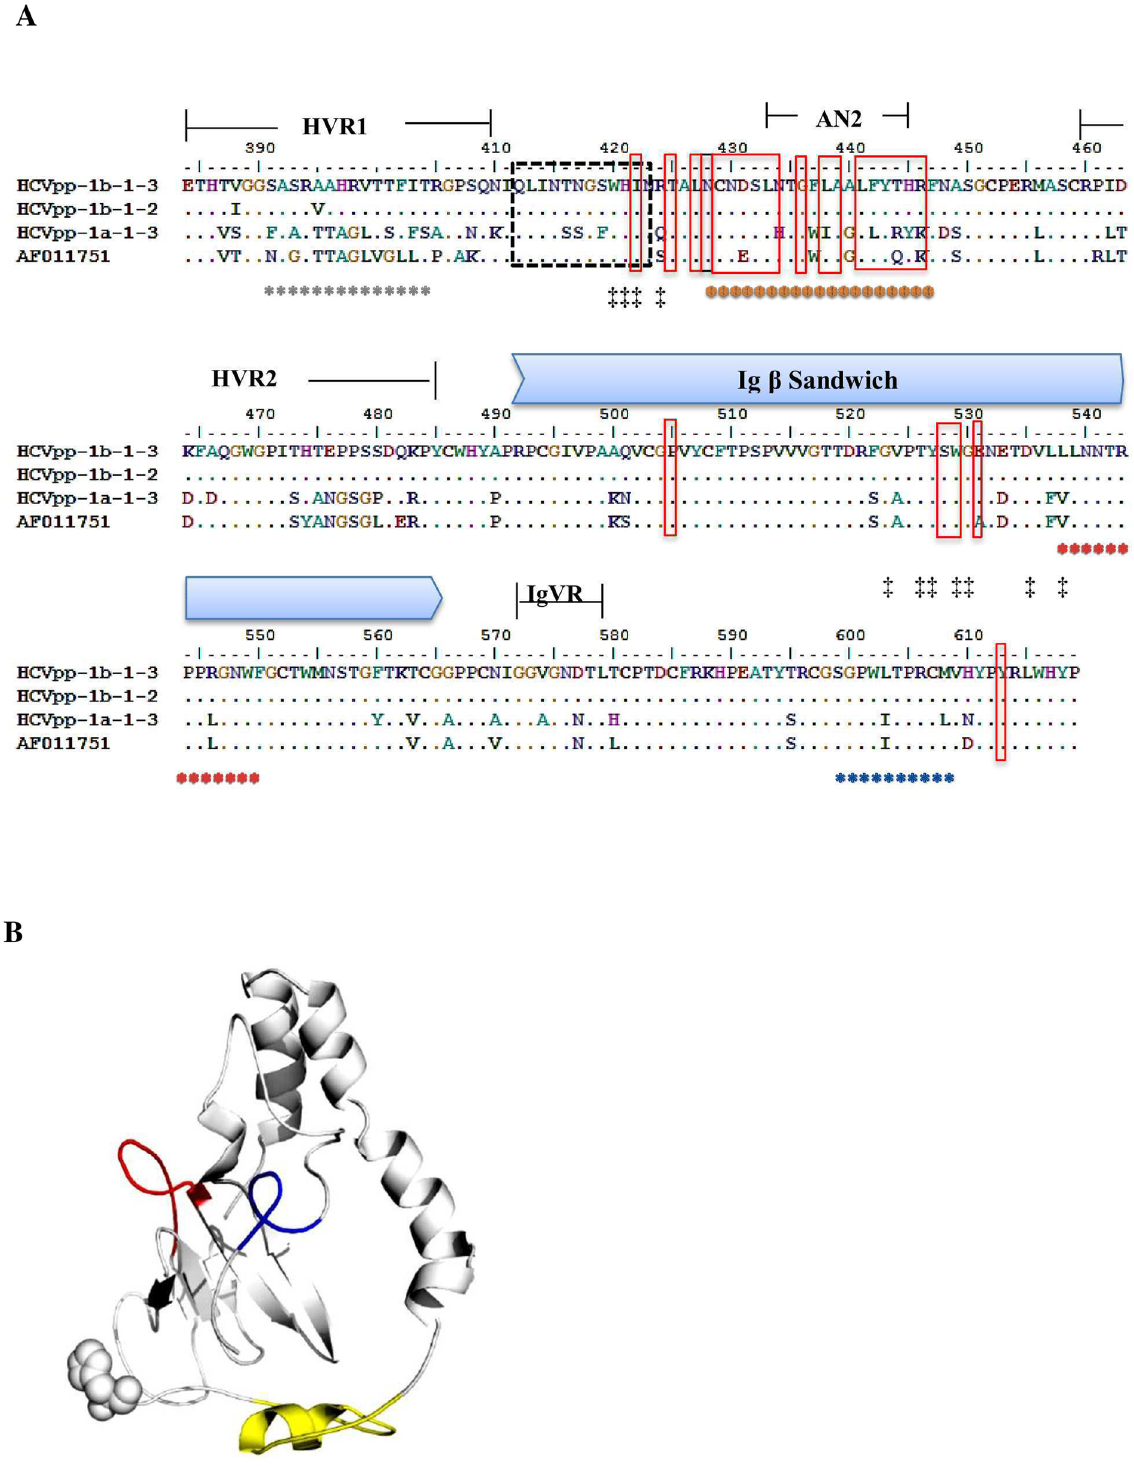
Fig 5. Conformational epitope mapping of E2 glycoprotein region starting from amino acid 384–619.A. The multiple sequencealignment(MSA) of the E2 glycoprotein. HCVpp1b-1-3 is a reference sequence;HCVpp1b-1-1,HCVpp1a-1-3 and HCVppH77 were the infectiouspseudoparticles. AF011751is an H77 strain. aa marked with * : targeted by patient derivedVF-Fabs. The colour code of the epitopes represent the positionof the epitopein 3D structure of E2 glycoprotein (Table 4); aa in dotted box: